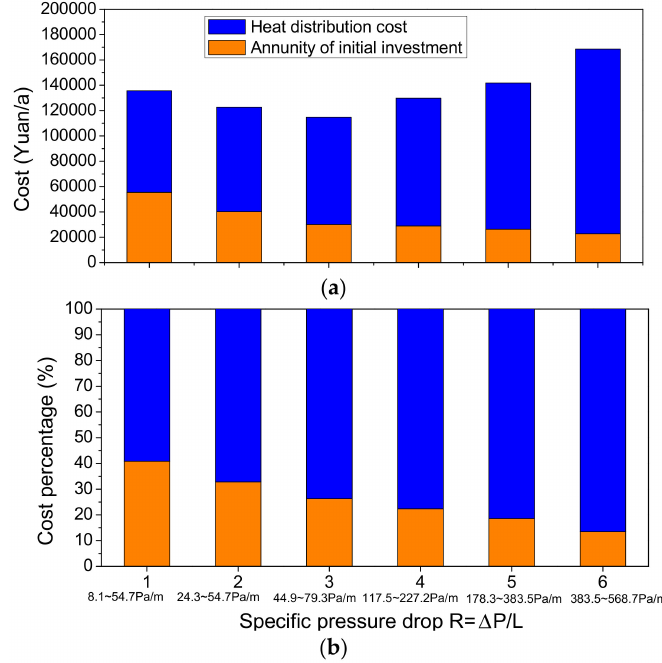
Figure 4. Comparison of the annuity on the initial investment and pump operating cost at different R values for the sample DH network with the intermediate pipe price and pump operating time. ( a ) Cost value; ( b ) cost